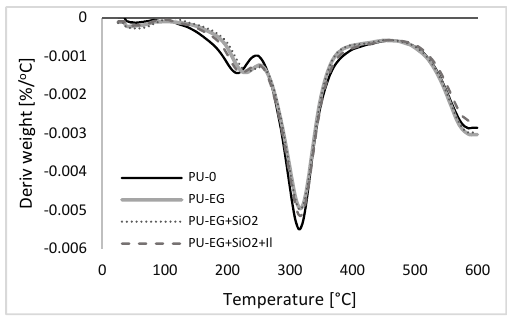
Figure 9. DTG graph plotted for PU foams.